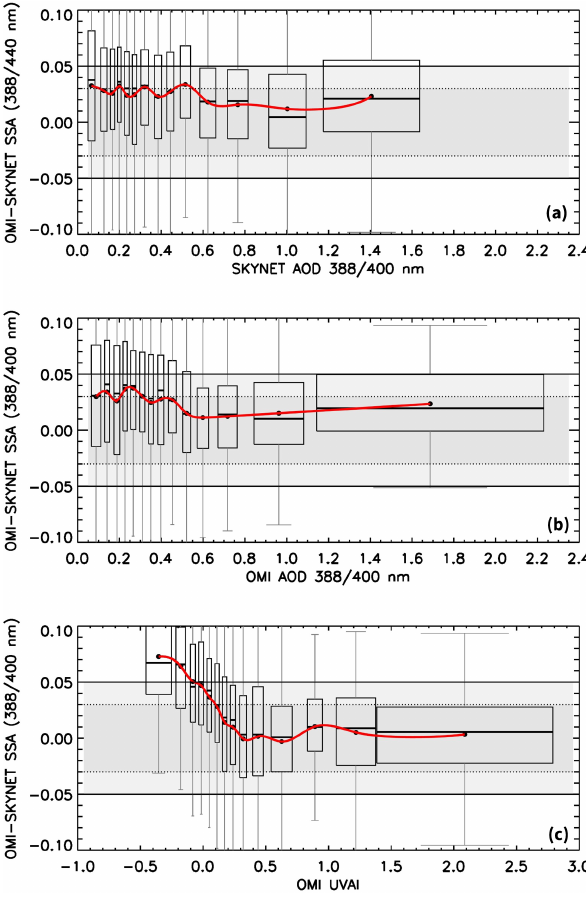
Figure 7. Difference in SSA between OMI and SKYNET as a function of the coincident SKYNET-measured (a) and OMI- retrieved (b) aerosol optical depth and OMI-measured UVAI (c) . Filled circles in black are the mean of the difference for each AOD and UVAI bin with an equal sample size of 200 matchups; horizon- tal lines represent the median of the bin samples; the shaded area in gray encompasses data within the 25th (lower) to 75th (higher) per- centile range, whereas vertical lines in gray represent 1.5 times the interquartile range (25th to 75th percentile). The dotted and solid horizontal lines are the uncertainty range of ± 0 . 03 and ± 0 . 05, re- spectively. The width of each box represents the 2 standard devia- tions of the data contained in the respective